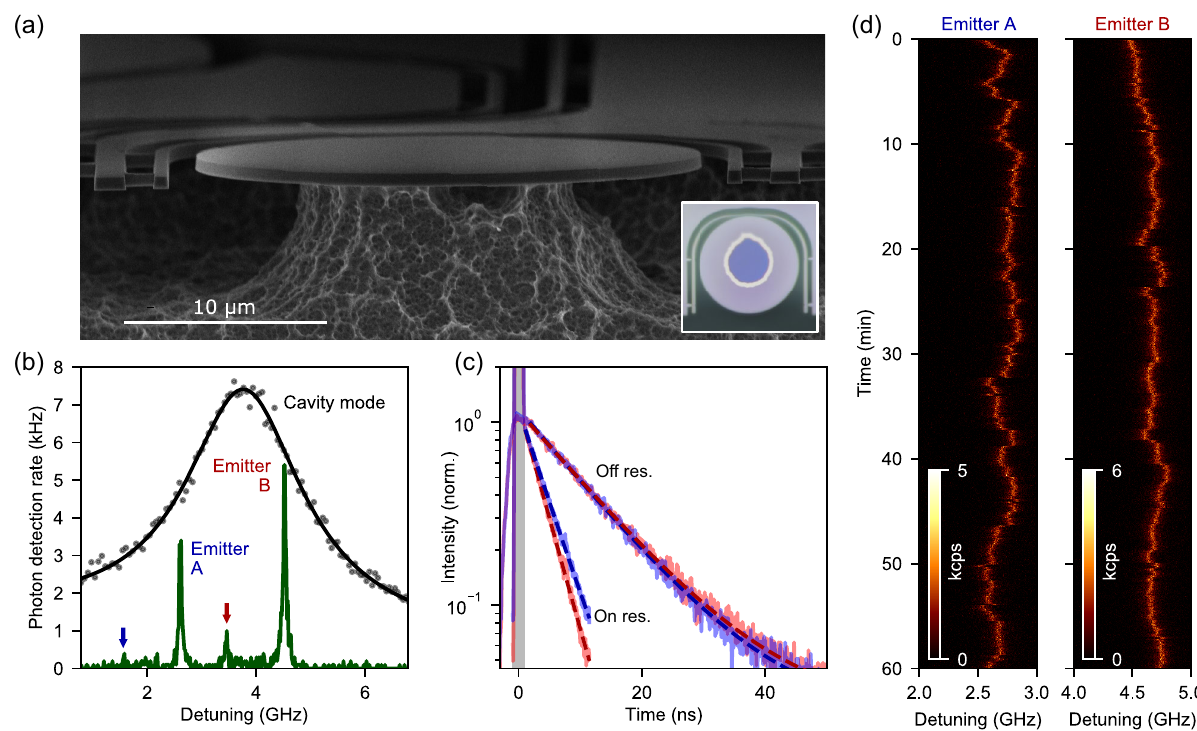
FIG. 1. Spectrally stable V emitters in integrated 4 H -SiCOI photonics. (a) Scanning electron micrograph of the device. Awaveguide, Si which wraps around the disk (seen in the optical microscope image, inset), is coupled to the resonator. A microscope objective is used to couple light to and from the flat facets of the waveguide. (b) A cavity photoluminescence spectrum (emitter PLE spectrum) in black (green), taken with a scanning resonant laser with 1 . 5 μ W (0.5 pW) of power in the waveguide. We extract a loaded cavity quality factor of Q ¼ 1 . 3 × 10 5 . The prominent peaks at 2.7 and 4.5 GHz detuning are the A 2 transitions of the two emitters. The corresponding A 1 transitions are labeled with arrows. In this figure and henceforth, laser detuning is relative to 327.113 THz (916.5 nm). (c) Lifetime measurements for emitter A (blue) and emitter B (red) on and off resonance with the cavity. The gray region represents the excitation pulse. (d) A one-hour PLE scan (3.6 s per line) of each emitter (while the other is selectively ionized into the dark state), with the cavity positioned on resonance with the